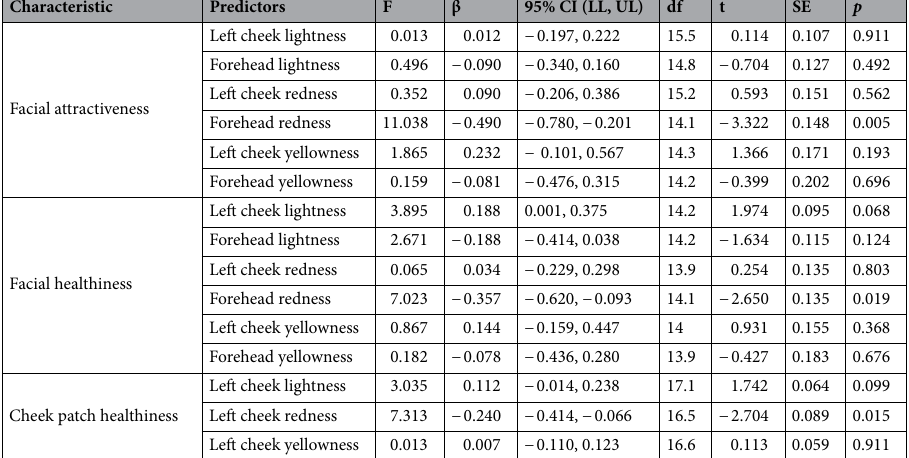
Table 6. Relationship between perceived characteristics and facial colouration. Facial attractiveness ratings: for target ID, VRC = 0.545, SD = 0.739, ICC = 0.299; for rater ID, VRC = 0.429, SD = 0.655, ICC = 0.251. Facial healthiness ratings: for target ID, VRC = 0.433, SD = 0.658, ICC = 0.228; for rater ID, VRC = 0.458, SD = 0.677, ICC = 0.238. Cheek patch healthiness ratings: for target ID, VRC = 0.244, SD = 0.493, ICC = 0.161; for rater ID, VRC = 0.490, SD = 0.7, ICC = 0.279. VRC variance of random components.